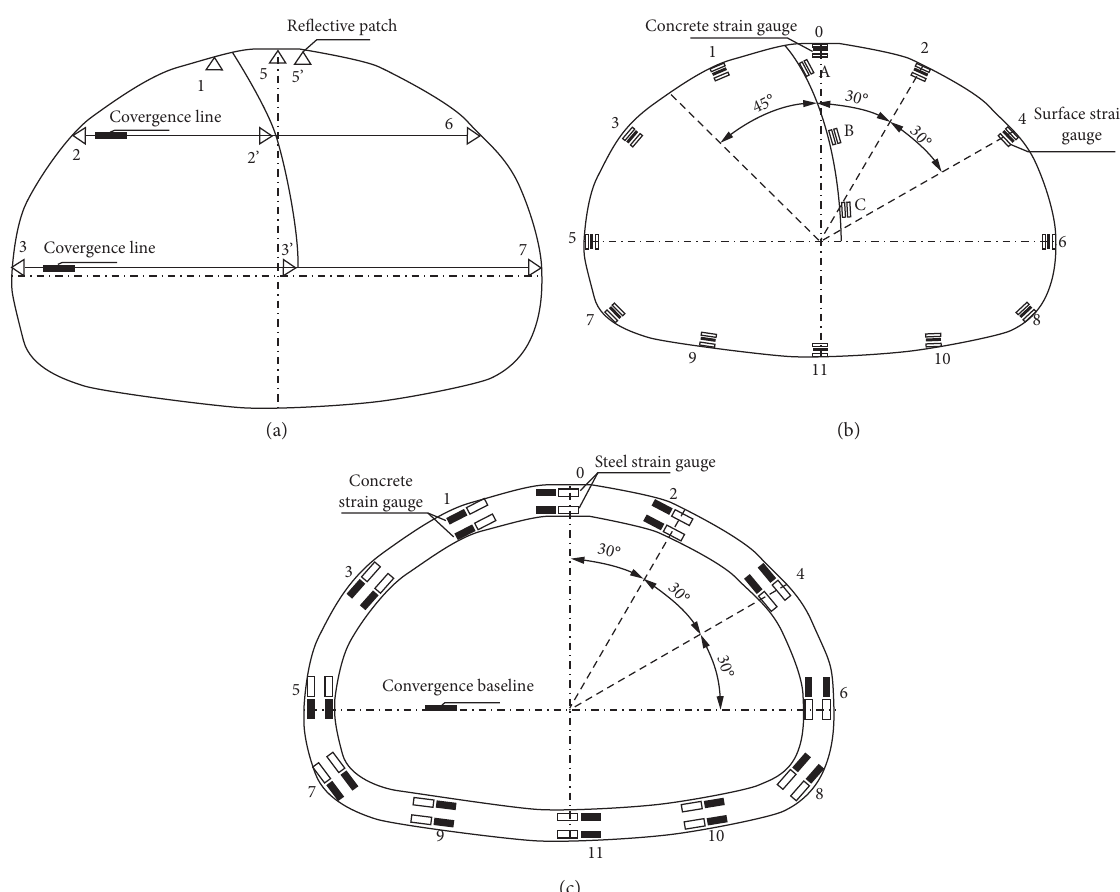
Figure 8: Layout of monitoring points in tunnel portal section. (a) Layout of deformation monitoring points. (b) Layout of stress monitoring points. (c) Layout of stress test points at secondary